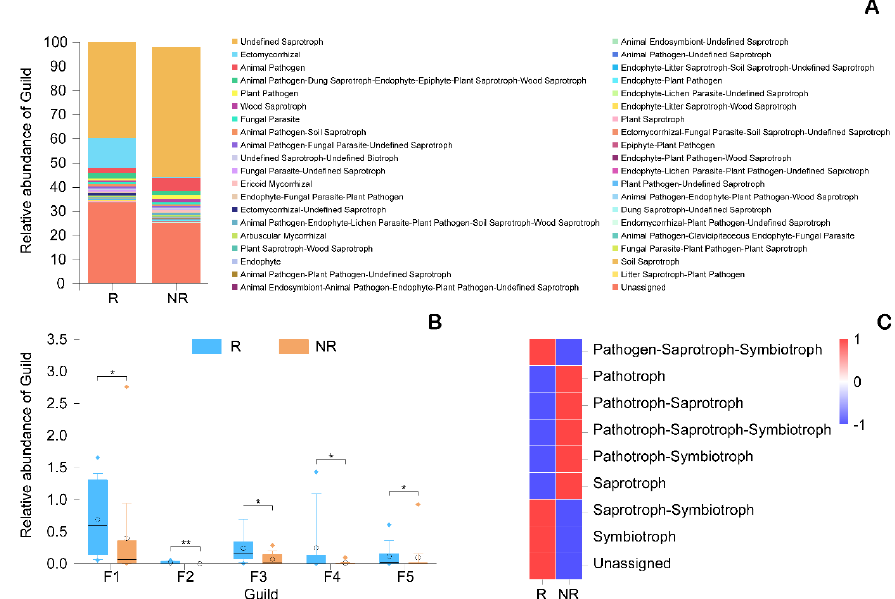
Figure 6. Distributed stack diagram ( A ) of fungal functional group (Guild), box figure of di ff erent fungal functional group (Guild) based on Wilcoxon rank-sum test ( B ), and the heatmap of fungal functional trophic mode ( C ). R and NR indicated the rhizosphere and non-rhizosphere, respectively. F1, F2, F3, F4, and F5 indicated Fungal Parasite-Undefined Saprotroph, Ectomycorrhizal-Undefined Saprotroph, Endophyte-Litter Saprotroph-Soil Saprotroph-Undefined Saprotroph, Endophyte-Litter Saprotroph-Wood Saprotroph, and Ectomycorrhizal-Fungal Parasite-Soil Saprotroph-Undefined Saprotroph. * and ** over the box indicated a significant di ff erence at 0.05 and 0.01 level, respectively. The black line and hollow cycle in the box indicated the median and mean ( n = 3) abundance of Guild, respectively. The solid rhombus beyond the box indicated the discrete data. The top and down line of box indicated 25% and 75% of Guild. The top and down line beyond the box indicated 10% and 90% of